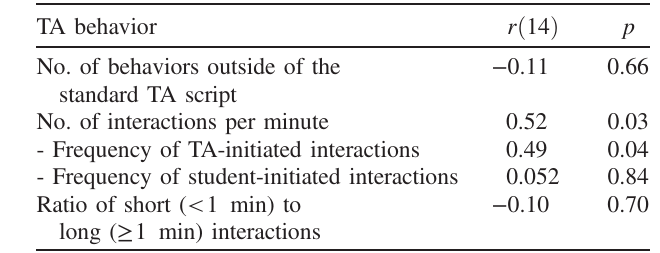
TABLE III. Correlation of TA behaviors with student engage- ment. At an α level of 0.05, the frequency of interactions and the frequency of TA-initiated interactions give the only statistically significant